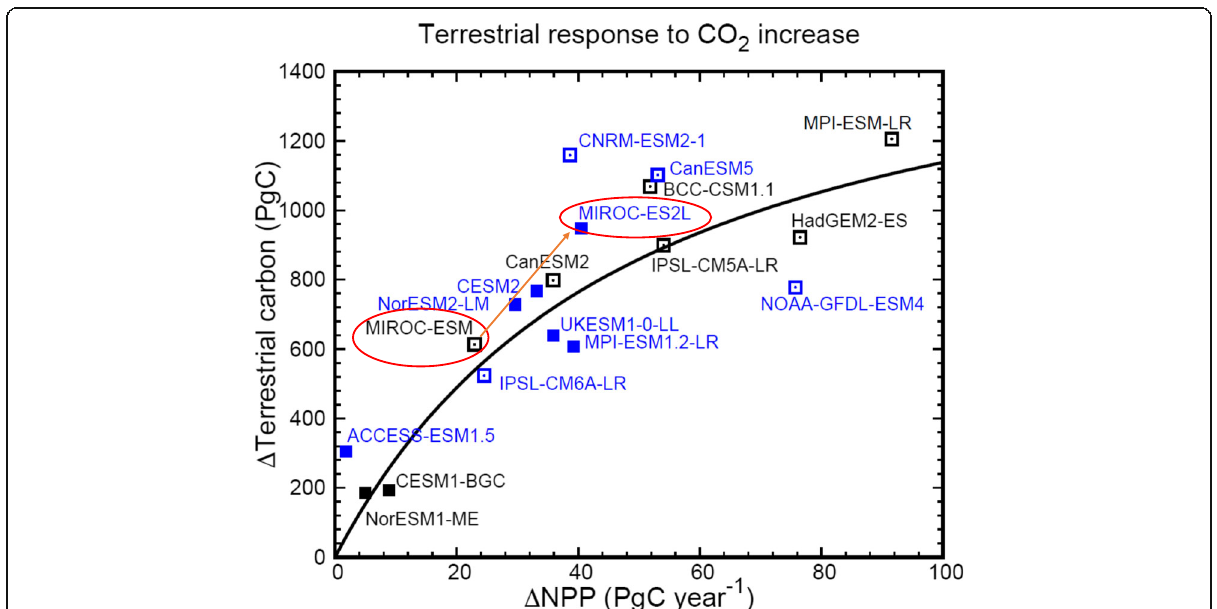
Fig. 2 Relationship between net primary production increments ( Δ NPP) and terrestrial carbon accumulation stimulated by atmospheric CO 2 increase in Coupled Model Intercomparison Project (CMIP) Phase 5 (black) and 6 (blue) models based on results from an idealized CMIP5 (Hajima et al. 2014a, 2014b) and CMIP6 (Arora et al. 2020) experiment in which CO 2 concentration was increased every year by 1% and the carbon cycle was assumed to be unaffected by temperature change. Increments were calculated as the difference between the last and first conditions of the experiments. Filled symbols indicate results from models with terrestrial carbon – nitrogen interactions. Solid curve indicates results from the analytical, simple algebraic model based on parameters of CMIP5 models, as proposed by Hajima et al. (2014b). Red ovals indicate results from MIROC series of